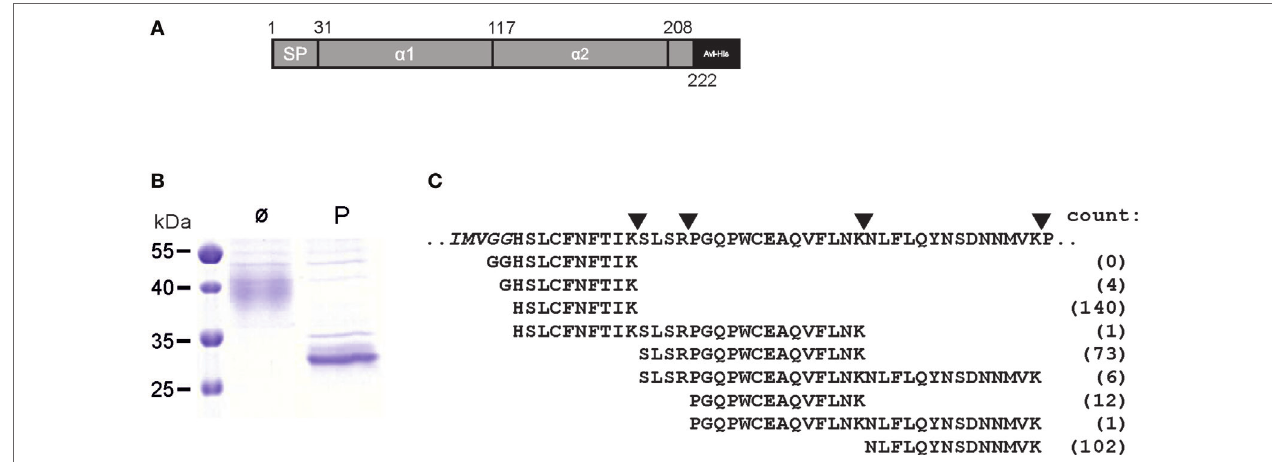
FigUre 2 | Aminoterminus of mature ULBP4 glycoproteins. (a) Scheme of soluble carboxyterminally truncated and tagged ULBP4 (stULBP4) used for mass spectrometric analyses. (B) Affinity-purified stULBP4 from supernatants of transfected 293F cells was treated either with PNGaseF (P) or left untreated (ø), separated by SDS-PAGE, and visualized by Coomassie staining. (c) Abundancy of aminoterminal stULBP4 fragments as determined by mass spectrometry. stULBP4 was digested with trypsin and LysC, and resulting fragments were analyzed and counted by mass